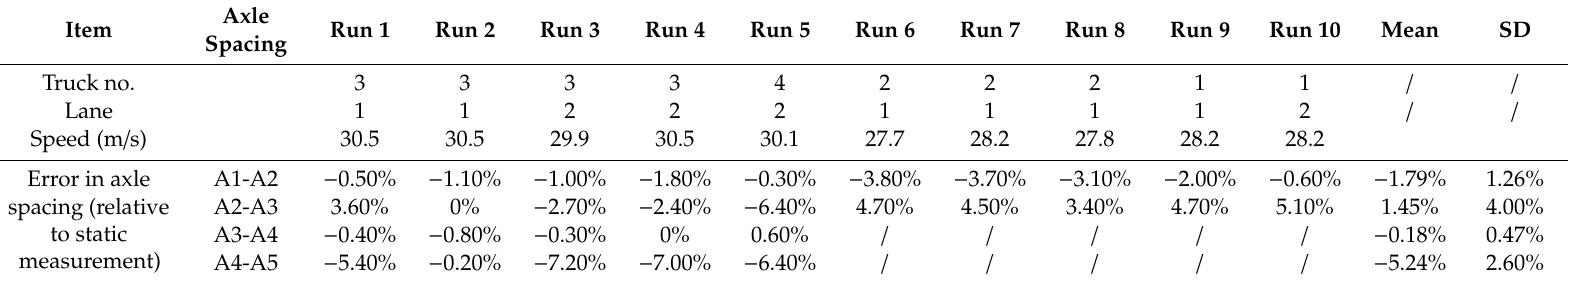
Table 4. Vehicle speeds and errors in axle